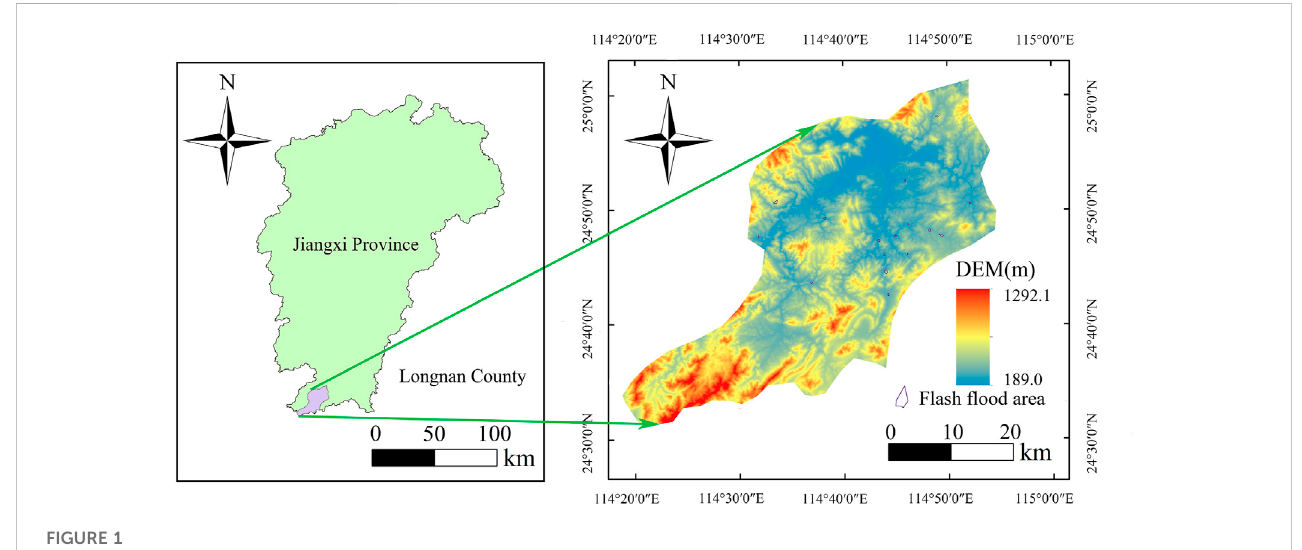
FIGURE 1 Overview of the study area and fl ash fl ood